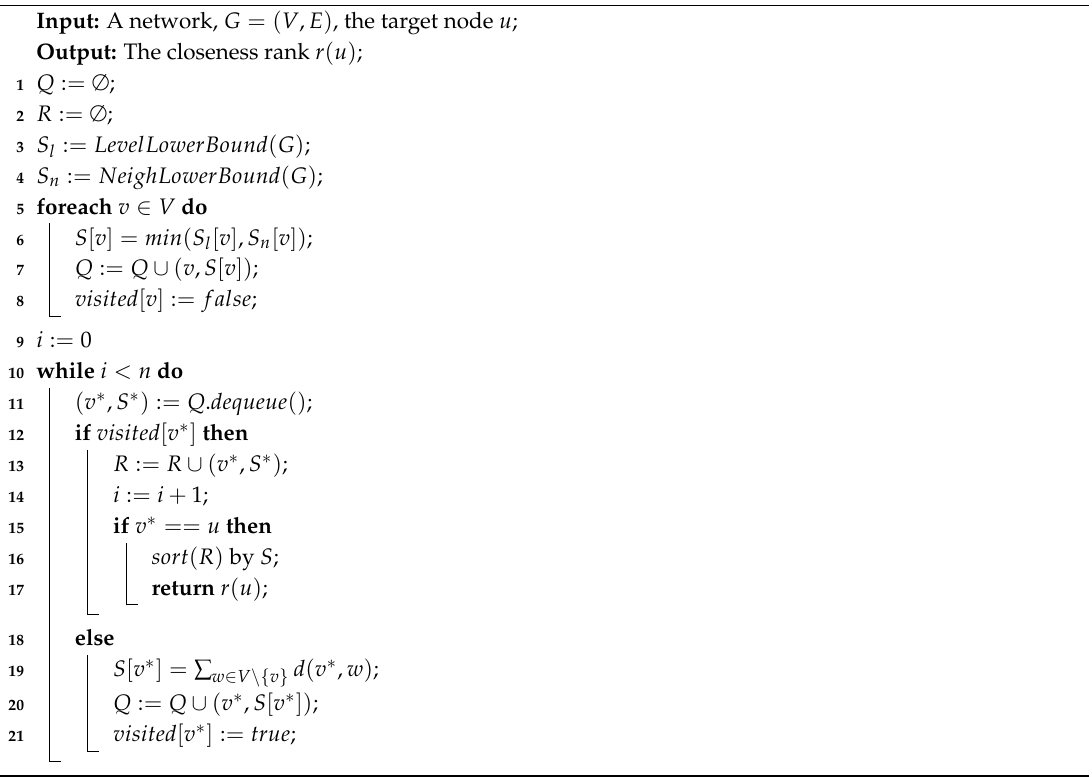
Algorithm 6: FastTopRank algorithm.